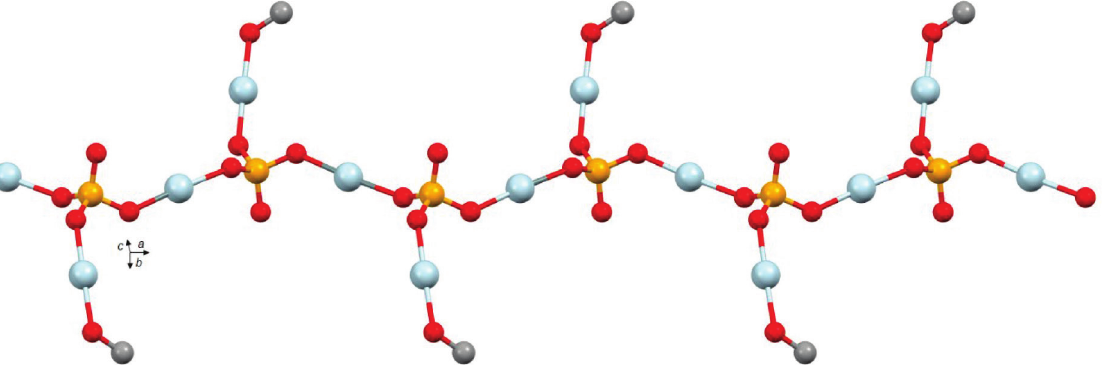
Figure 2: The infinite chain of 1 propagating along the a -axis (Mercury view) [Sn (light blue), Se (yellow), O (red), C (grey)]. Hydrogen atoms and phenyl groups are omitted for